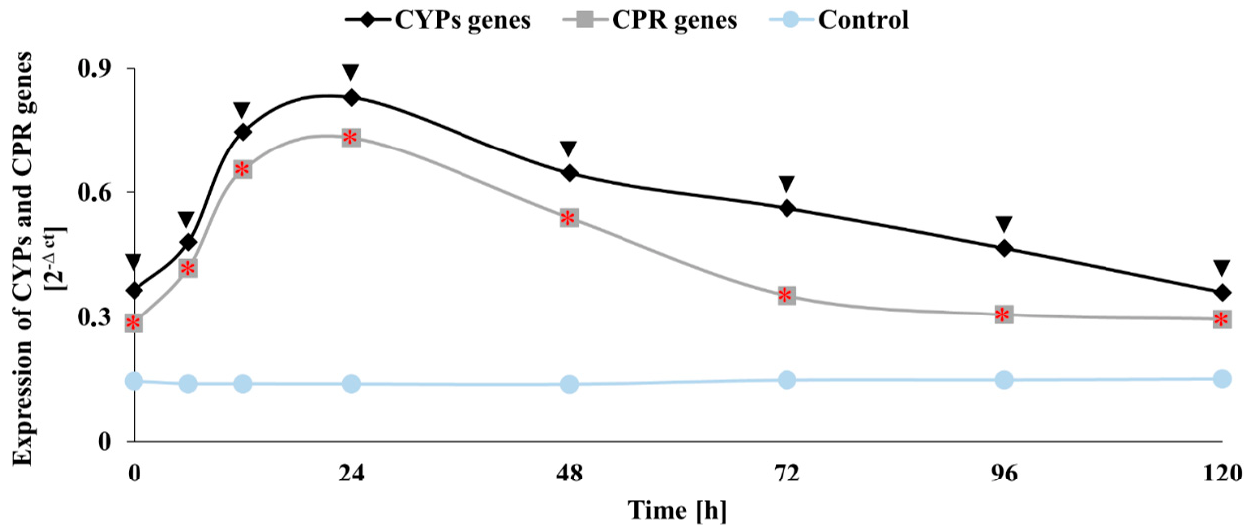
Figure 3. The expression of cytochrome P450 and cytochrome P450 reductase genes in the cells of C. elegans incubated with the addition of PCMX at a concentration of 25 mg L − 1 compared to the control without the xenobiotic. Each result represents an average ± SD ( n = 3). Statistical analysis was performed using the Mann–Whitney U test ( (cid:72) p < 0.05—a statistically significant increase in CYP450s genes relative to the biotic control; * p < 0.05—a statistically significant increase of CRP genes relative to the biotic